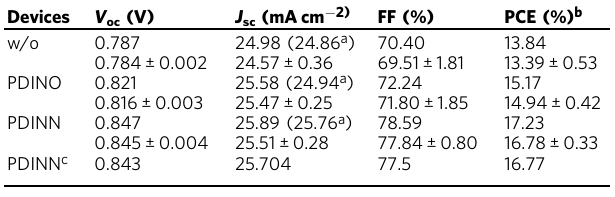
Table 2 Photovoltaic performance of the OSCs base on PM6: Y6 with Ag as cathode under the illumination of AM 1.5 G, 100 mW cm − 2